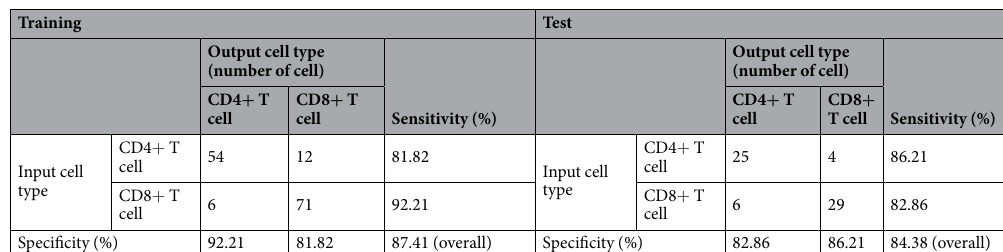
Table 2. Detailed performance of the CD4 + and CD8 + T lymphocyte cell type classifiers. The identification accuracy and its sub-parameters, sensitivity and specificity, were also